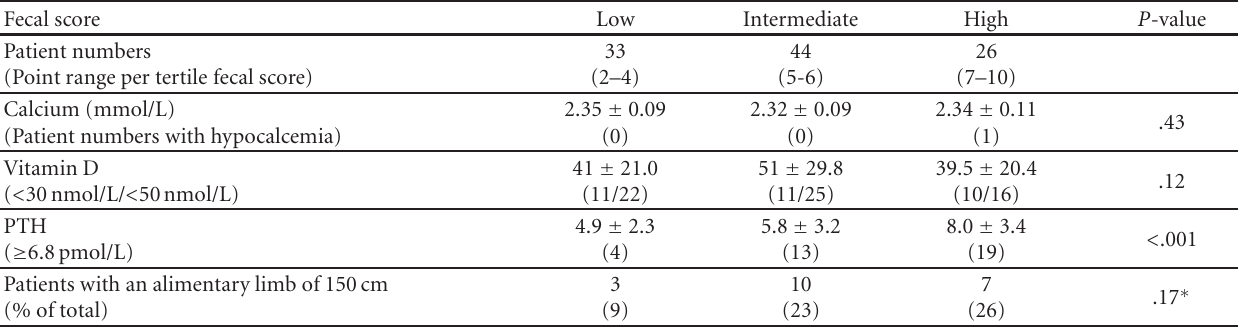
Table 4: Laboratory results according to fecal scores calculated for each